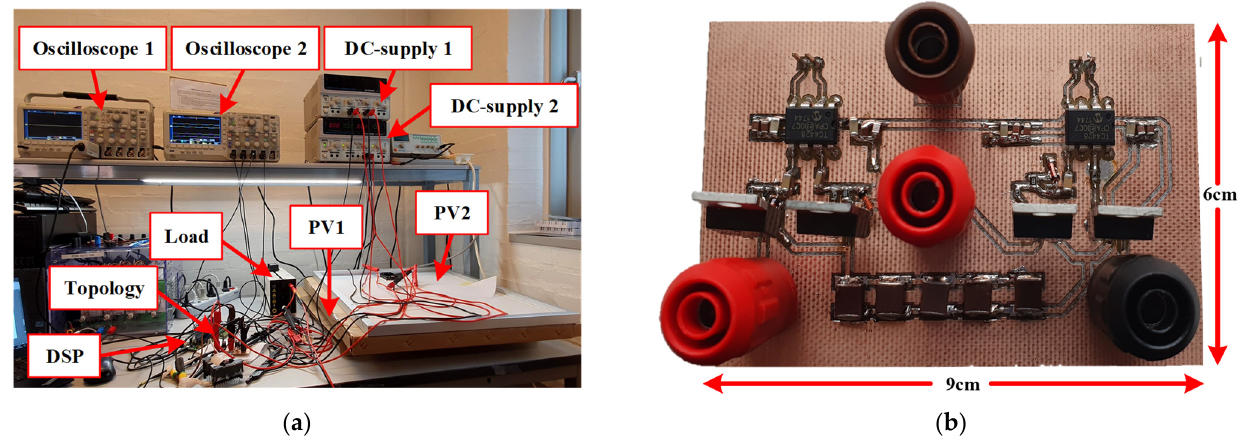
Figure 11. Photograph showing: ( a ) Complete experimental setup, ( b ) Designed prototype.